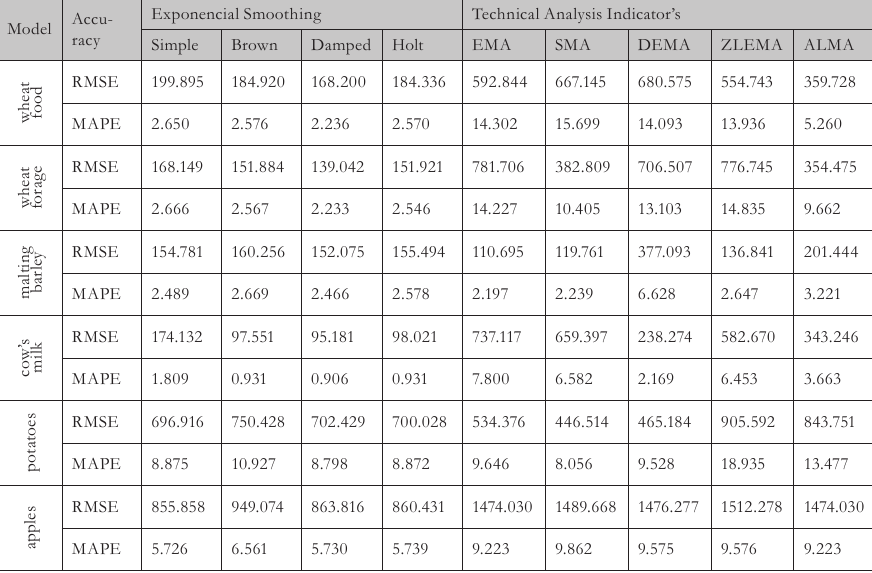
Tab. 5 – Accuracy of the best Optimized Models. Source: